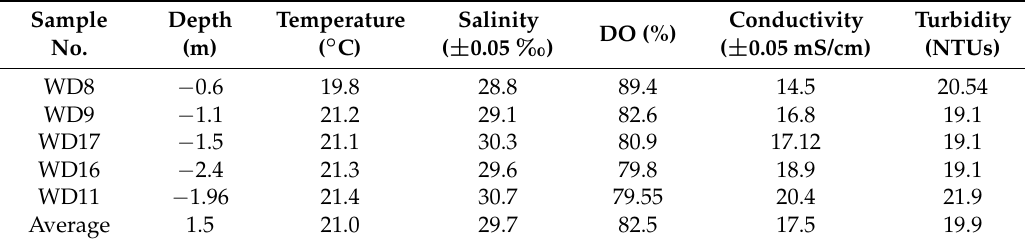
Table 3. Profile depth and analysis of water temperature, salinity, dissolved oxygen (DO), conductivity and turbidity.